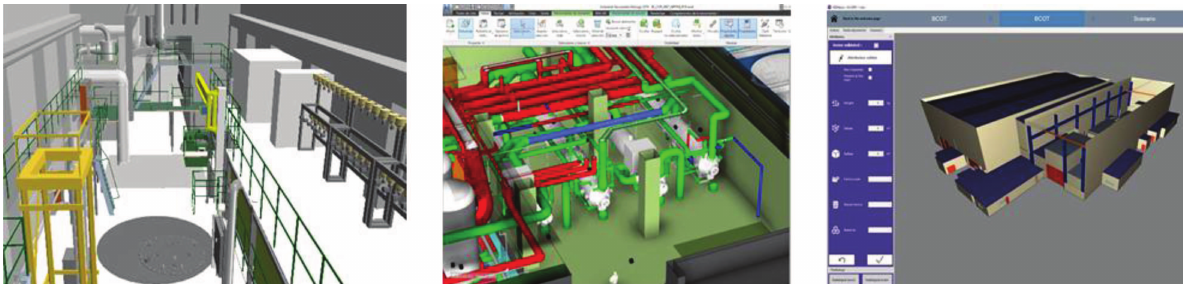
Fig. 4. 3D models of the nuclear facilities provided by IFE (left), ENRESA (middle) and EDF (right).